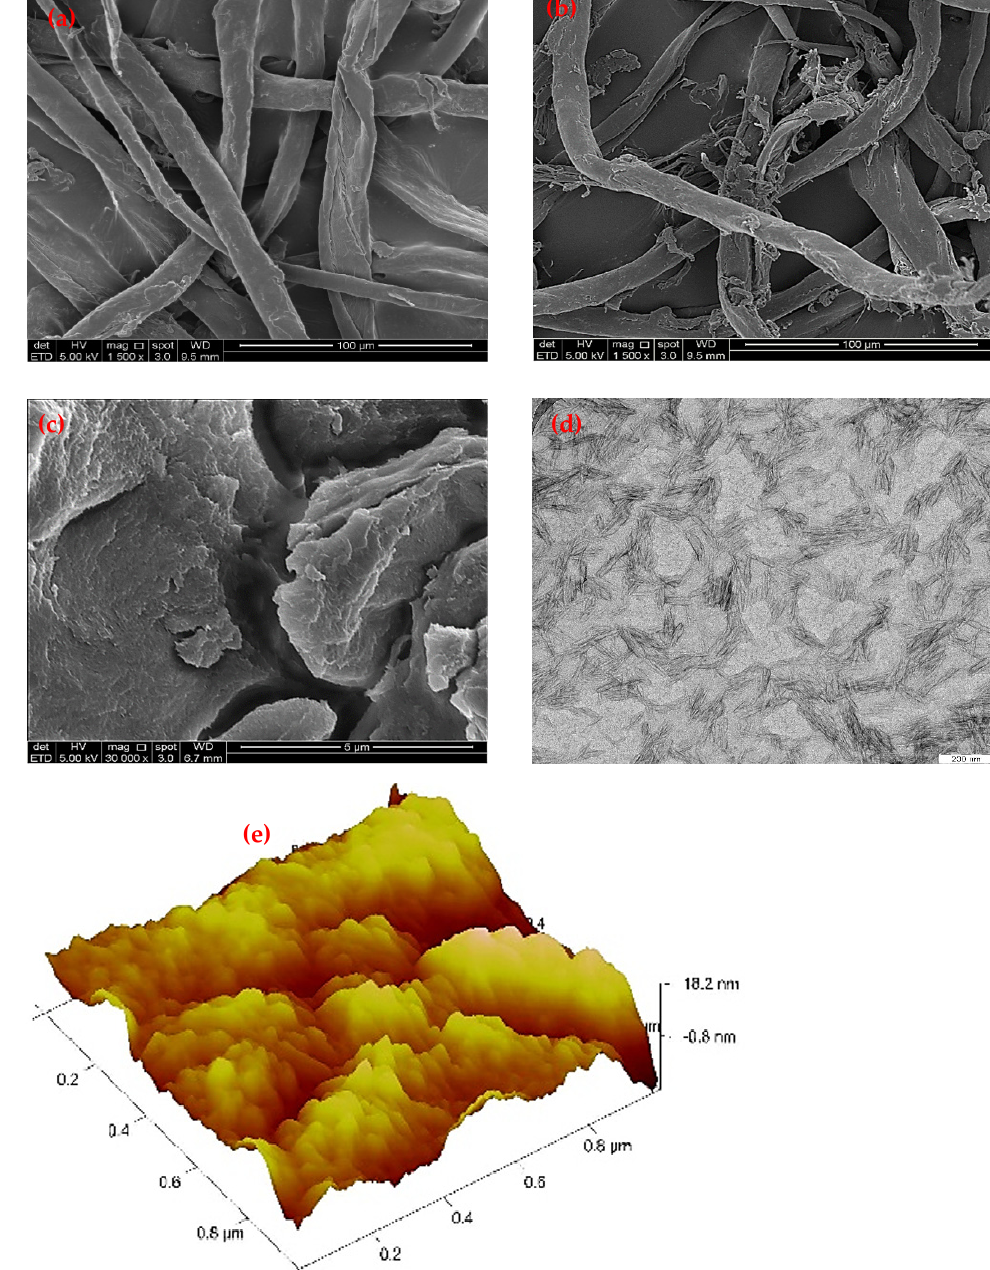
Figure 1. SEM image of waste cotton cloths ( a ), SEM image of scCO 2 pulped fibre ( b ), SEM image of CNCs ( c ), TEM image of CNCs ( d ), and AFM image of CNCs ( e ).